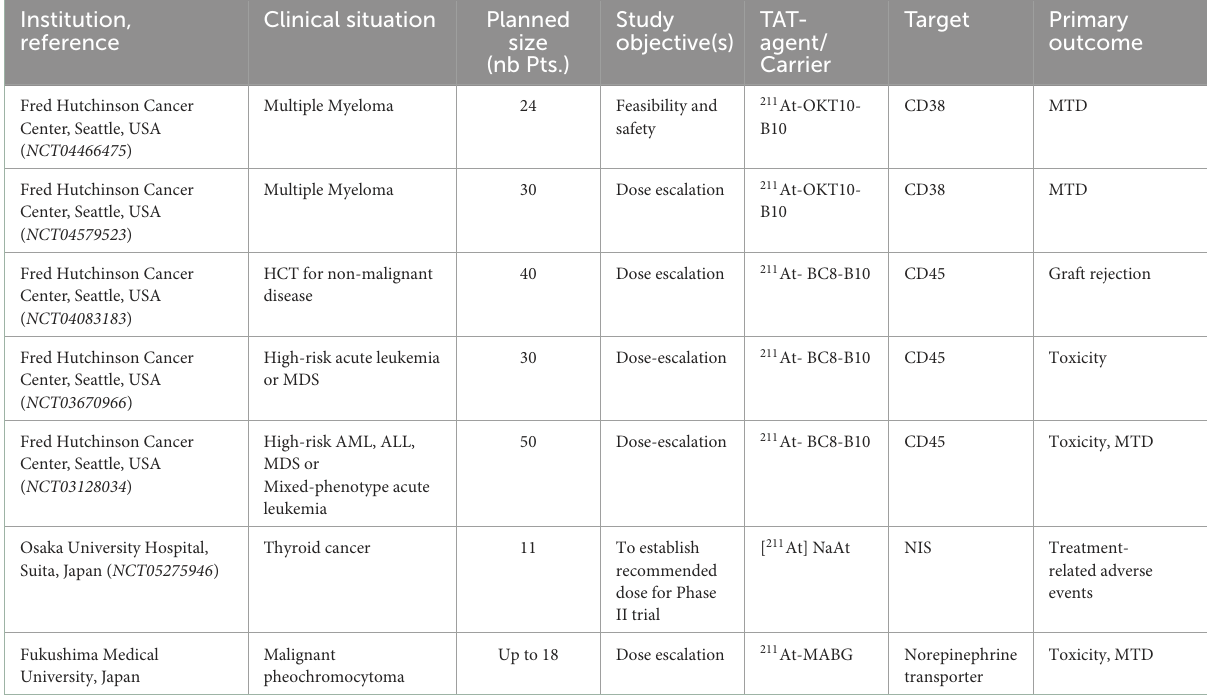
TABLE 2 Ongoing and planned clinical trials with 211 At. (NTC number) is the ClinicalTrials.gov identifier. Institution,